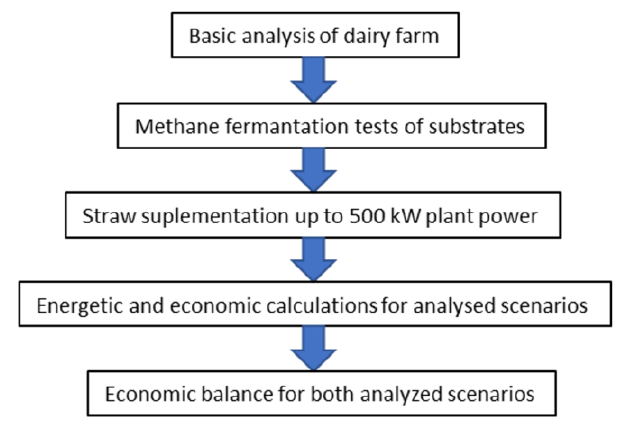
Figure 1. Methodological procedures for the energetic and economic analysis of both scenarios.